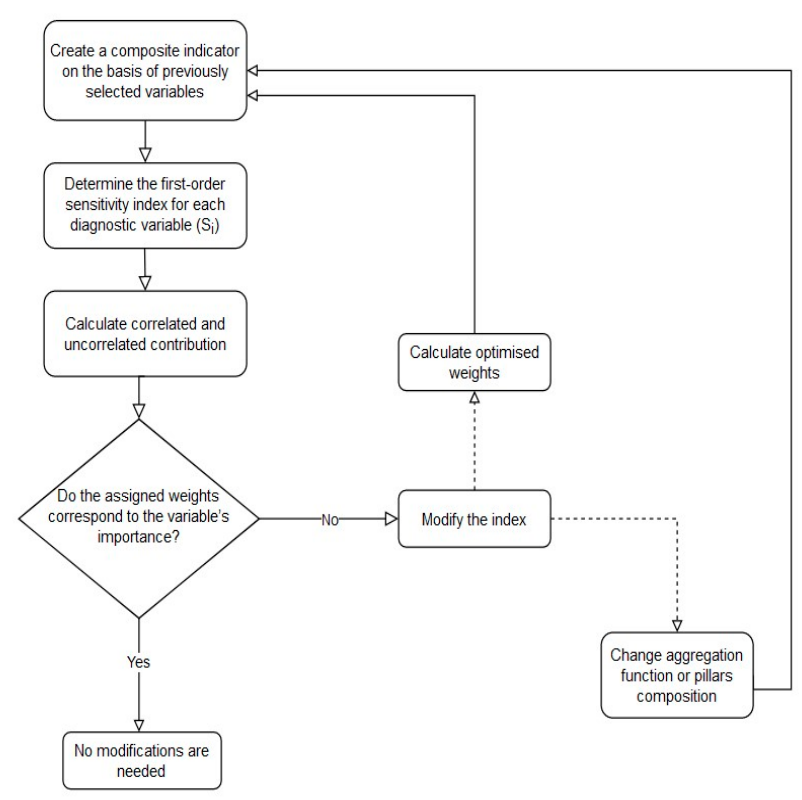
Figure 2. Composite indicator’s compliance testing procedure.